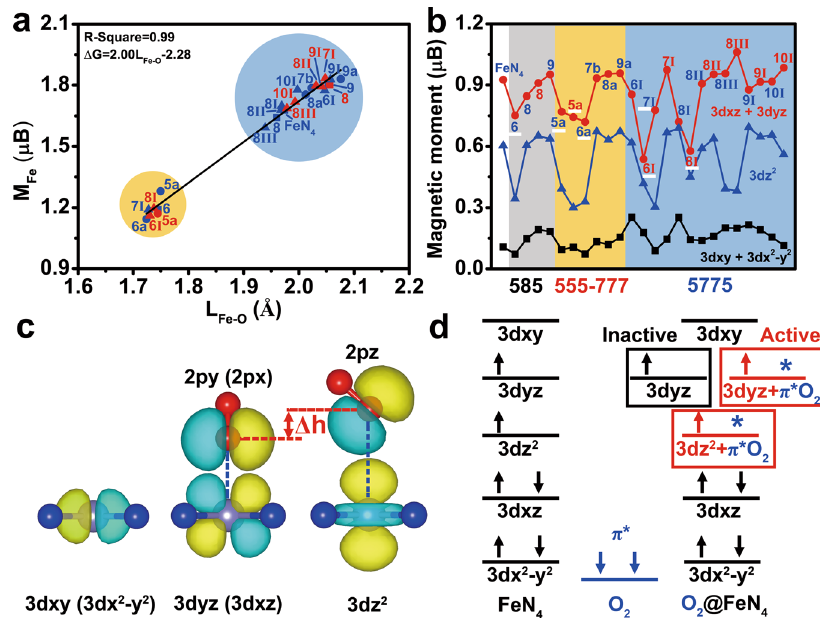
Fig. 4 Correlation mechanisms between descriptors. a Correlation between the Fe – O bond length and magnetic moment of Fe site. b The magnetic moment of the 3 dxy + 3 dx 2 – y 2 , 3 dyz + 3 dxz and 3 dz 2 orbital at the Fe site. c The spatial distribution of Fe 3 dxy (3 dx 2 – y 2 ), 3 dyz (3 dxz ), 3 dz 2 , and O 2 2 π * orbital. d The schematic frontier orbital diagram of Fe-N 4 , O 2 , and O 2 @Fe-N 4